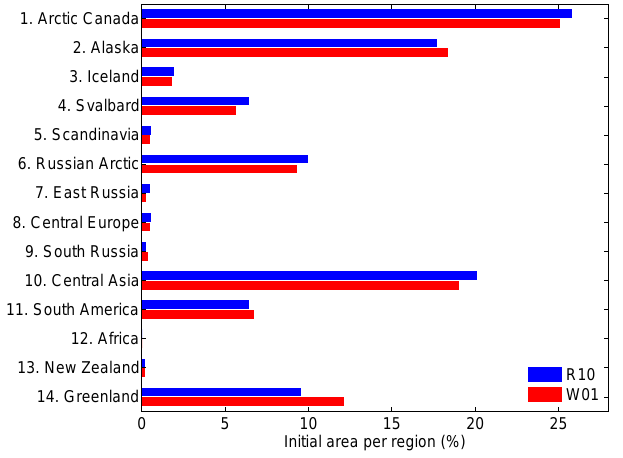
Fig. 1. Relative initial GIC area per region for the two glacier in- ventories.